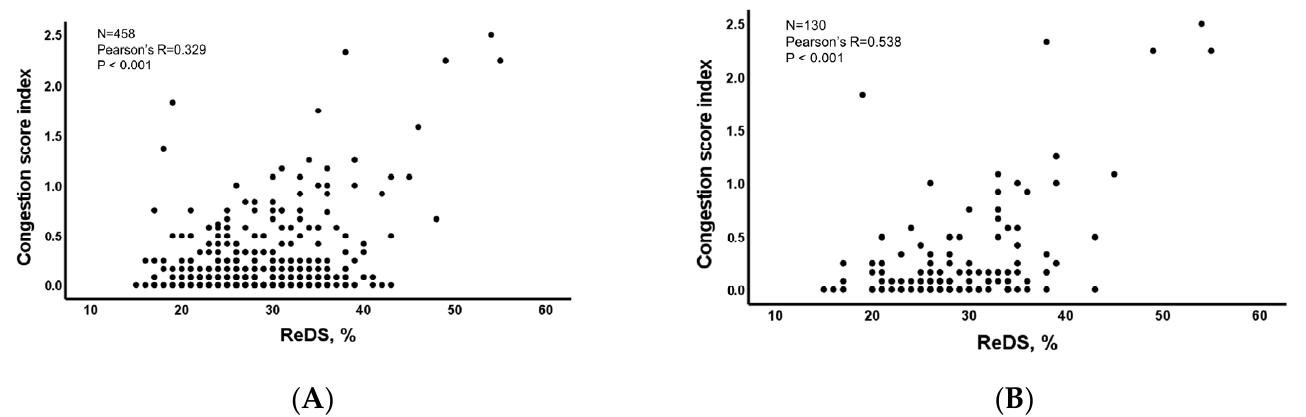
Figure 3. ( A ) The correlation between ReDS values and congestion score index in patients without lung diseases, ( B ) the correlation between ReDS values and congestion score index in heart failure patients without lung diseases. p -value < 0.05 by Pearson’s correlation.